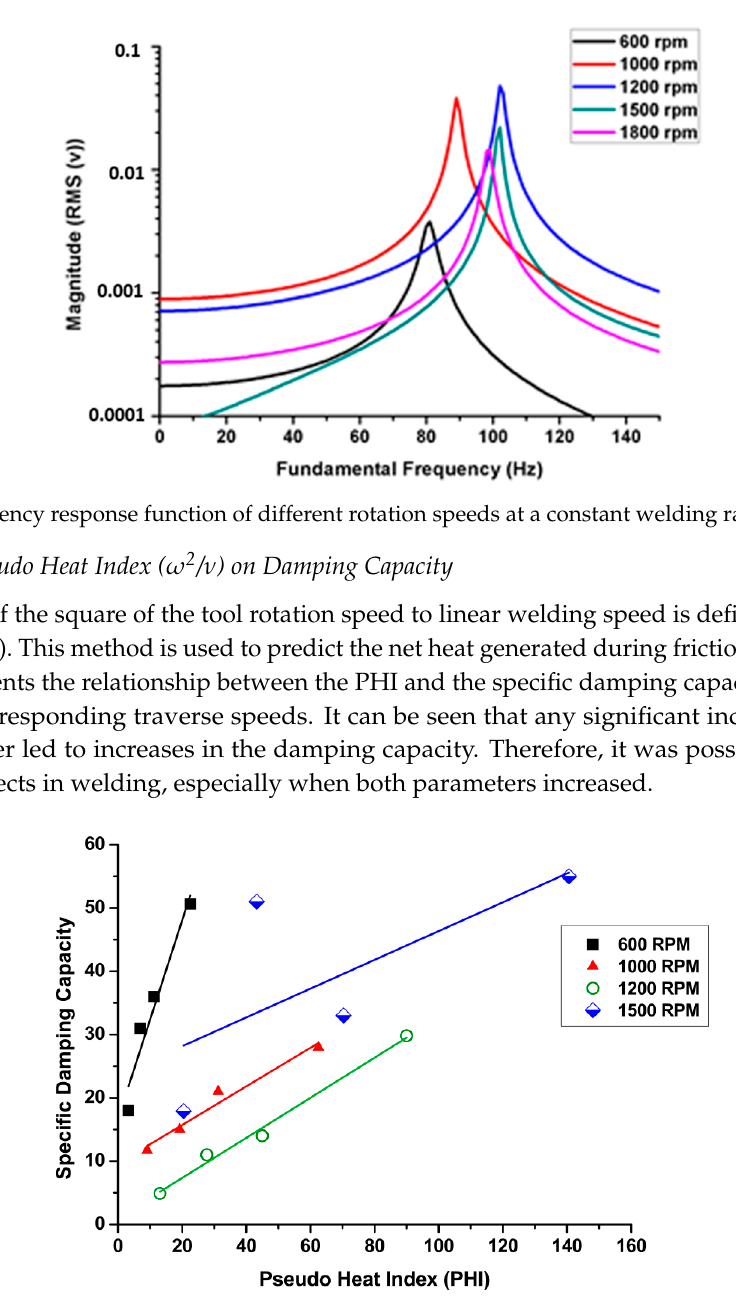
Figure 9. Effect of pseudo heat index (PHI) on damping capacity.